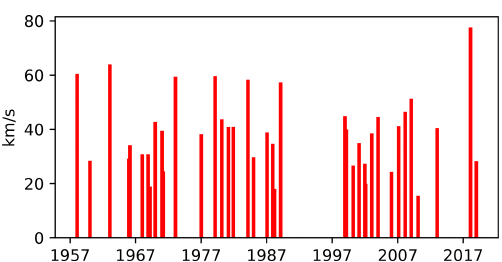
Figure A1. Eddy heat flux at 100hPa (kms − 1 ) averaged across 50–75 ◦ N observed over 5d prior to a major SSW during 1958–2018. The dates of the SSWs are taken from Charlton and Polvani (2007) and Karpechko (2018). The heat flux in 1979–2018 was calculated using ERA-I reanalysis, while in 1958–1978 it was using the ERA-40 reanalysis (Uppala et al., 2005).